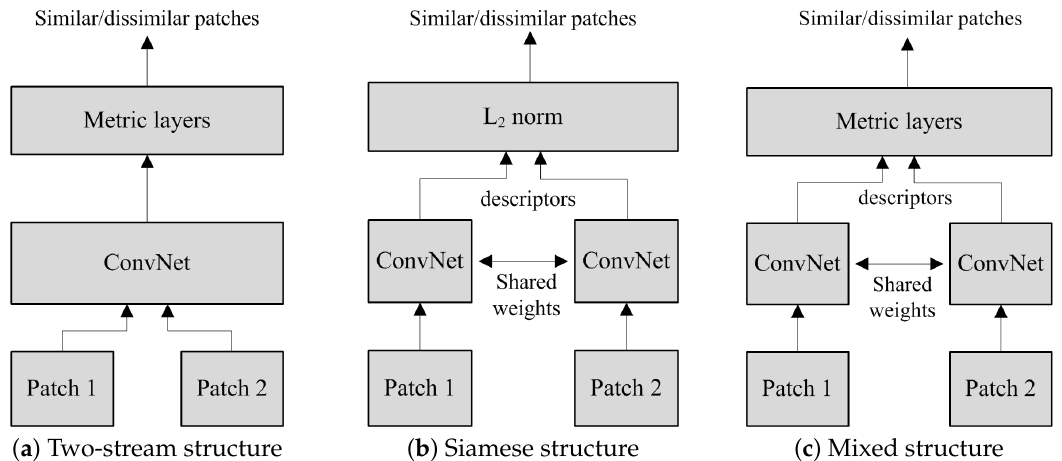
Figure 1. Convolutional neural network (CNN) architectures for measuring similarity between image